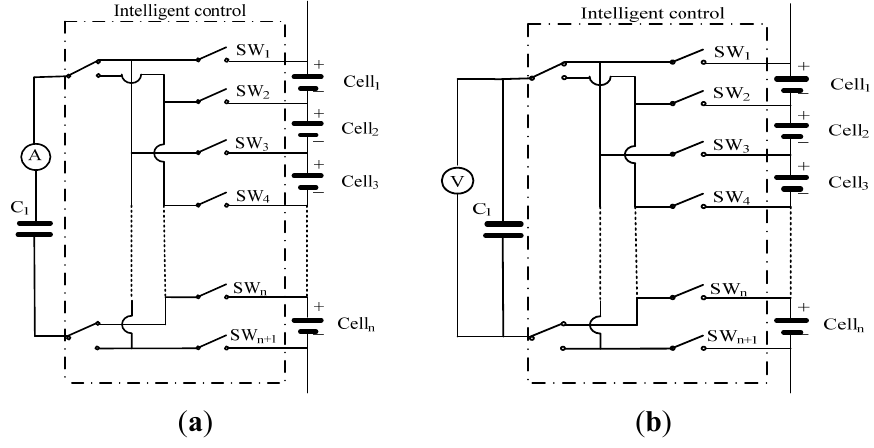
Figure 1. Single switched capacitor topology with ( a ) current sensor and ( b ) voltage